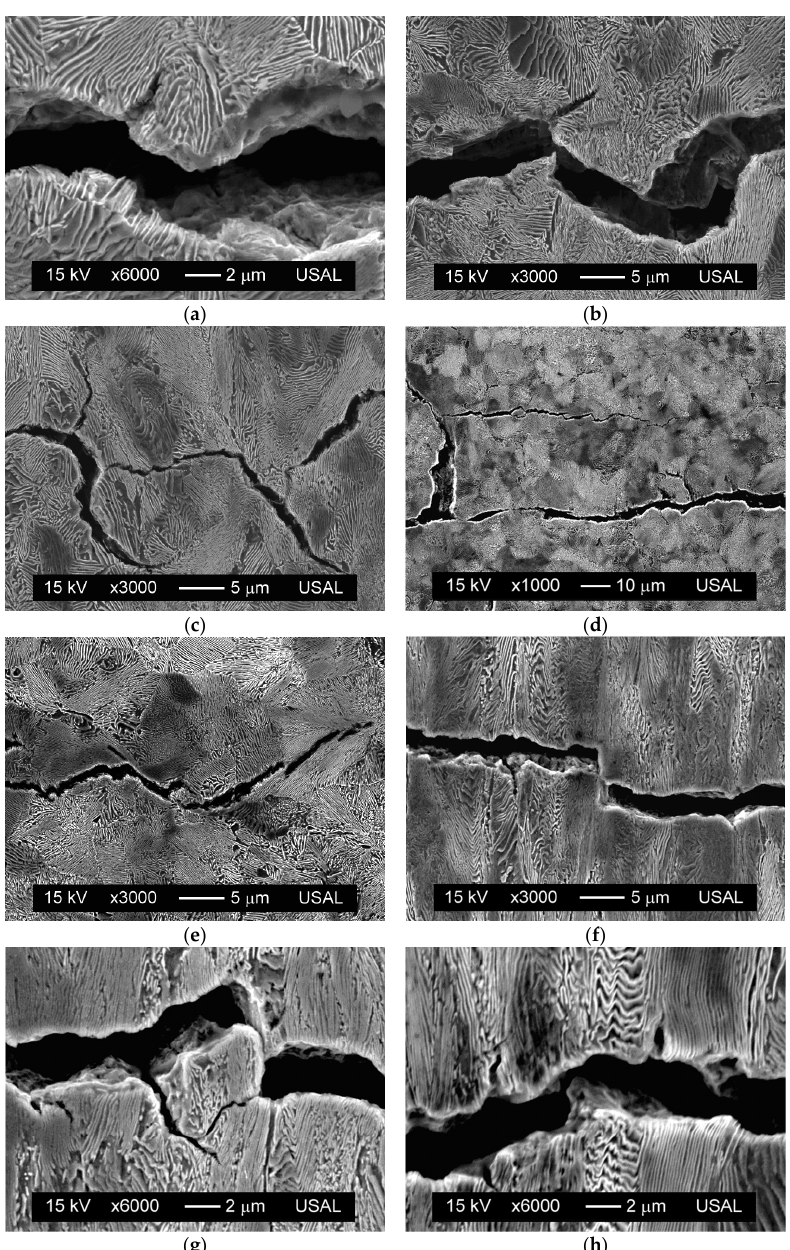
Figure 3. Crack paths, Δ K = 25 ÷ 40 MPam 1/2 : ( a ) micro ‐ damage; ( b ) deflection; ( c ) branching; ( d ) multi ‐ cracking; ( e ) micro ‐ discontinuity; ( f ) interlock; ( g ) debris; ( h ) pearlite pseudo ‐ colony. ( d ) multi-cracking; ( e ) micro-discontinuity; ( f ) interlocking; ( g ) debris; ( h ) pearlite